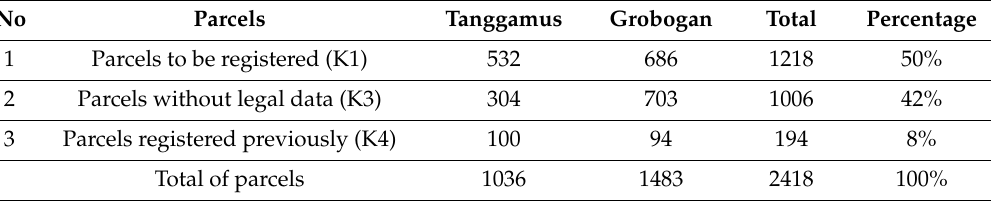
Table 3. PaLaR land parcels of Tanggamus and Grobogan pilots .